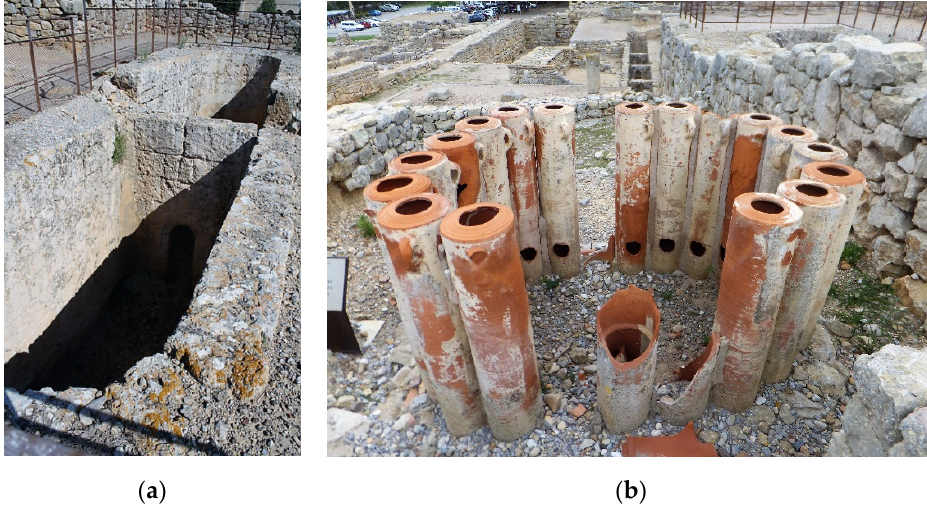
Figure 5. Cistern ( a ) and ceramic water filters ( b ) in the Asclepieion in the Hellenistic city of Emporiae, which is located in the northwestern coastal area of Catalonia, Spain [21] .